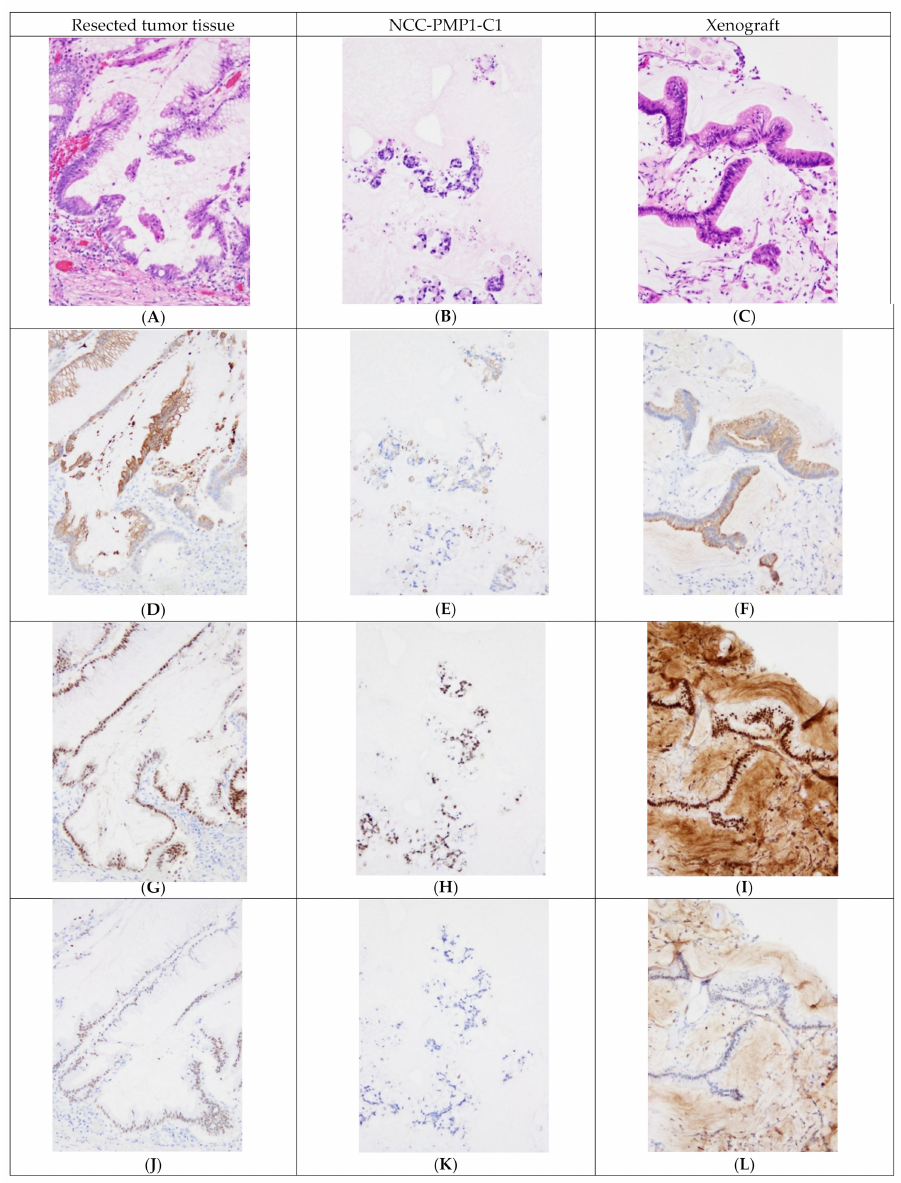
Figure 6. Representative histological and immunohistochemical findings of the surgically resected tumor (first column, × 200), corresponding established cell line (second column, × 200), and patient- derived xenograft (PDX) (third column, × 200). The first row ( A – C ) demonstrates the images of hematoxylin and eosin (H&E) staining; the second row ( D – F ) shows the images stained with anti- CK20 antibody; the third row ( G – I ) exhibits the images stained with anti-CDX2 antibody; and the fourth row ( J – L ) shows the images stained with anti-SATB2 antibody. In the surgically resected tumor ( A ), an appendiceal mucinous tumor composed of tumor cells showing dilated glands and papillary structure with abundant extracellular mucin is shown. These tumor cells were positive for CK20, CDX2, and SATB2 ( D , G , J ). The cell line established from the tumor ( B ) shows cohesive cell clusters with abundant extracellular mucous. Moreover, these cells were focally positive for CK20, CDX2, and SATB2 ( E , H , K ). The tumor from the PDX ( C ) was composed of mucinous tumor cells forming a papillary structure and small tumor cell clusters in the mucous pool. These tumor cells showed focal positivity for CK20 ( F ) and SATB2 ( L ) and diffuse positivity for CDX2 ( I